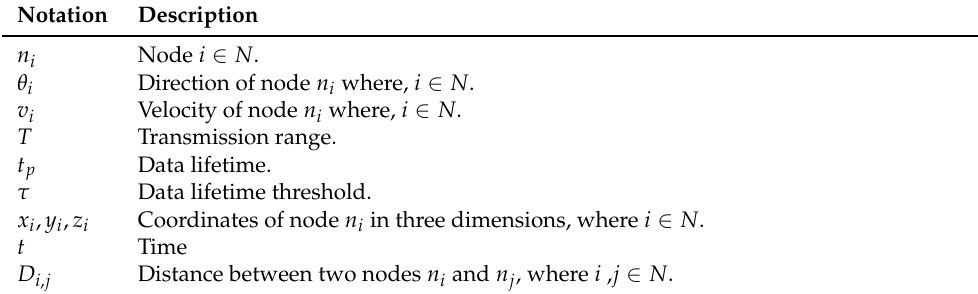
Table 1. General